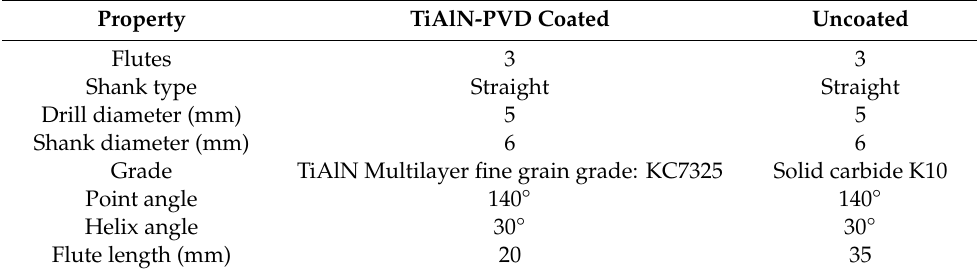
Table 2. Properties of twist drills.